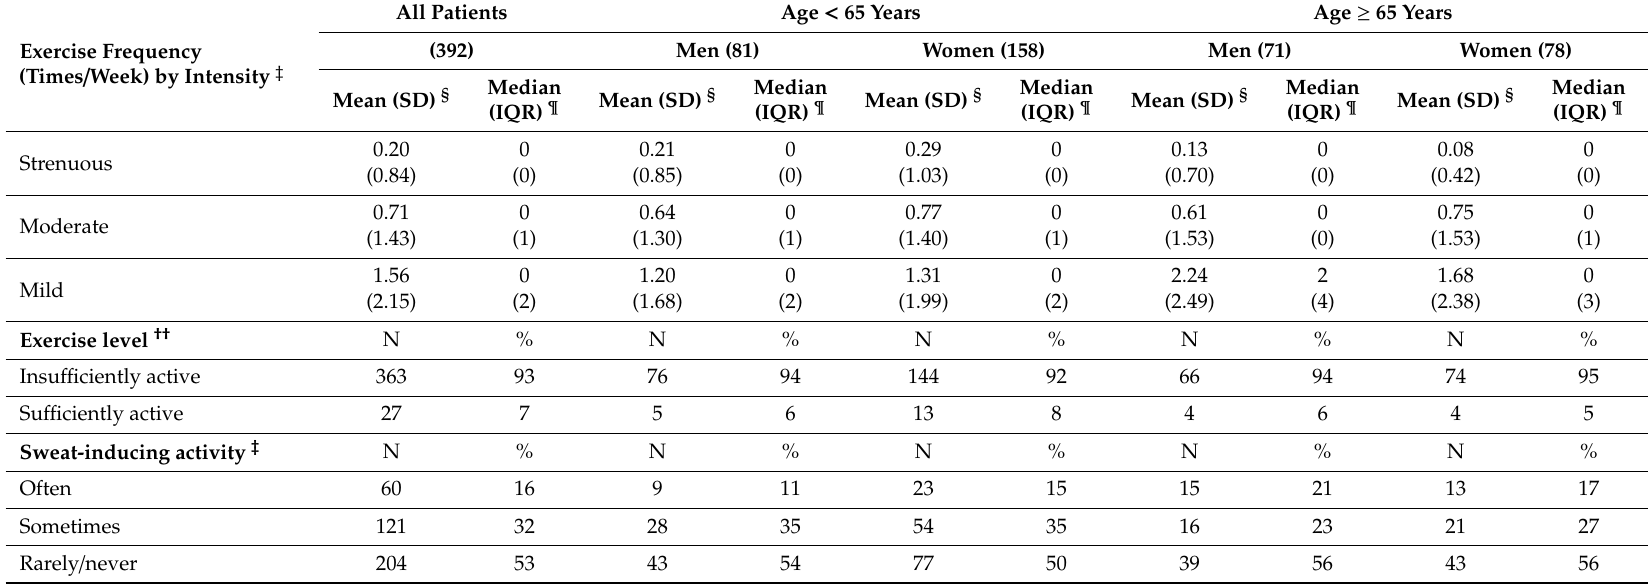
Table 2. Characteristics of preceding week’s exercise in cancer patients † by age and